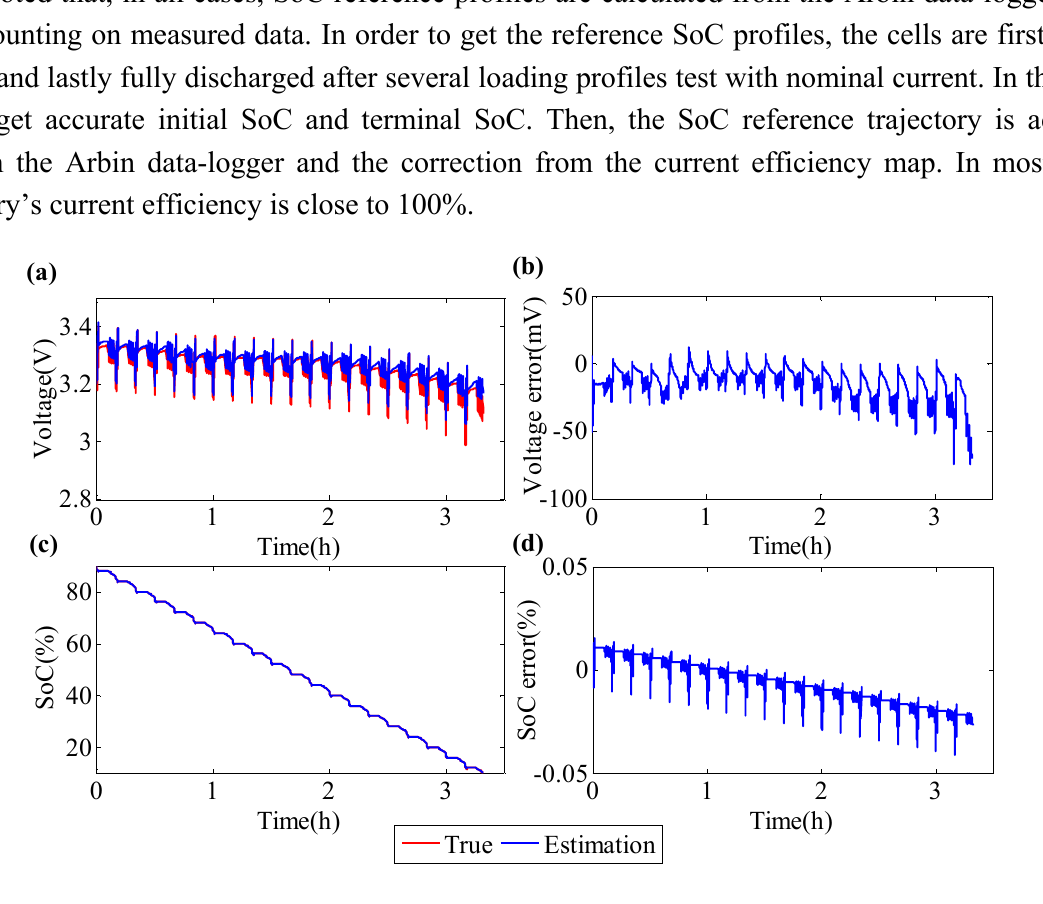
Figure 13. SoC estimation results with the accurate initial SoC of the LiFePO 4 cell: ( a ) Voltage; ( b ) Voltage error; ( c ) SoC; ( d ) SoC